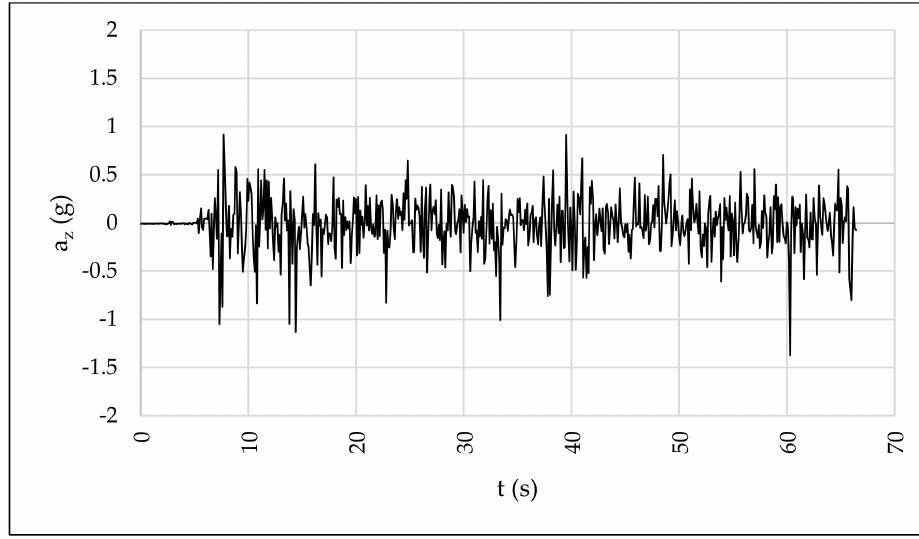
Figure 10. Vertical accelerations during data collection.